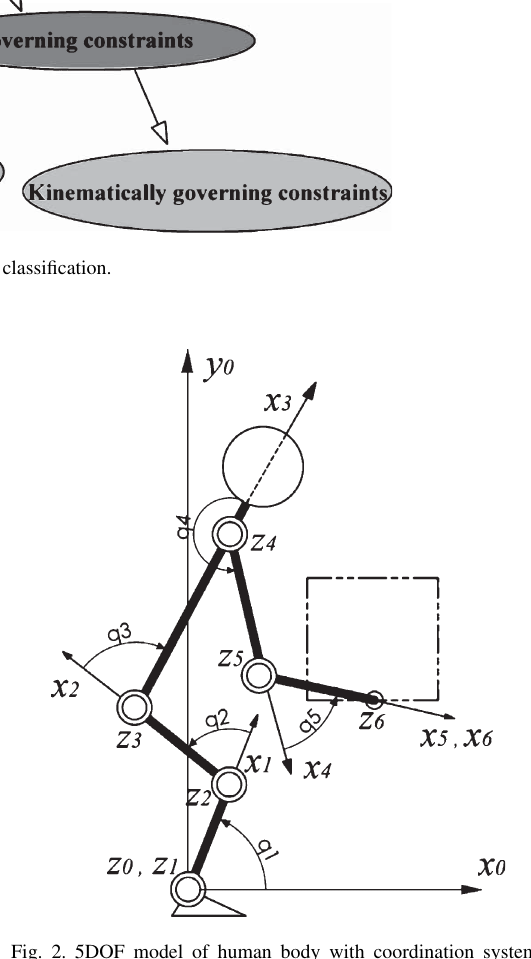
Fig. 2. 5DOF model of human body with coordination systems attached to each link. q 1 ,q 2 ,q 3 ,q 4 ,q 5 shows the angular position of ankle, knee, hip, shoulder, and elbow